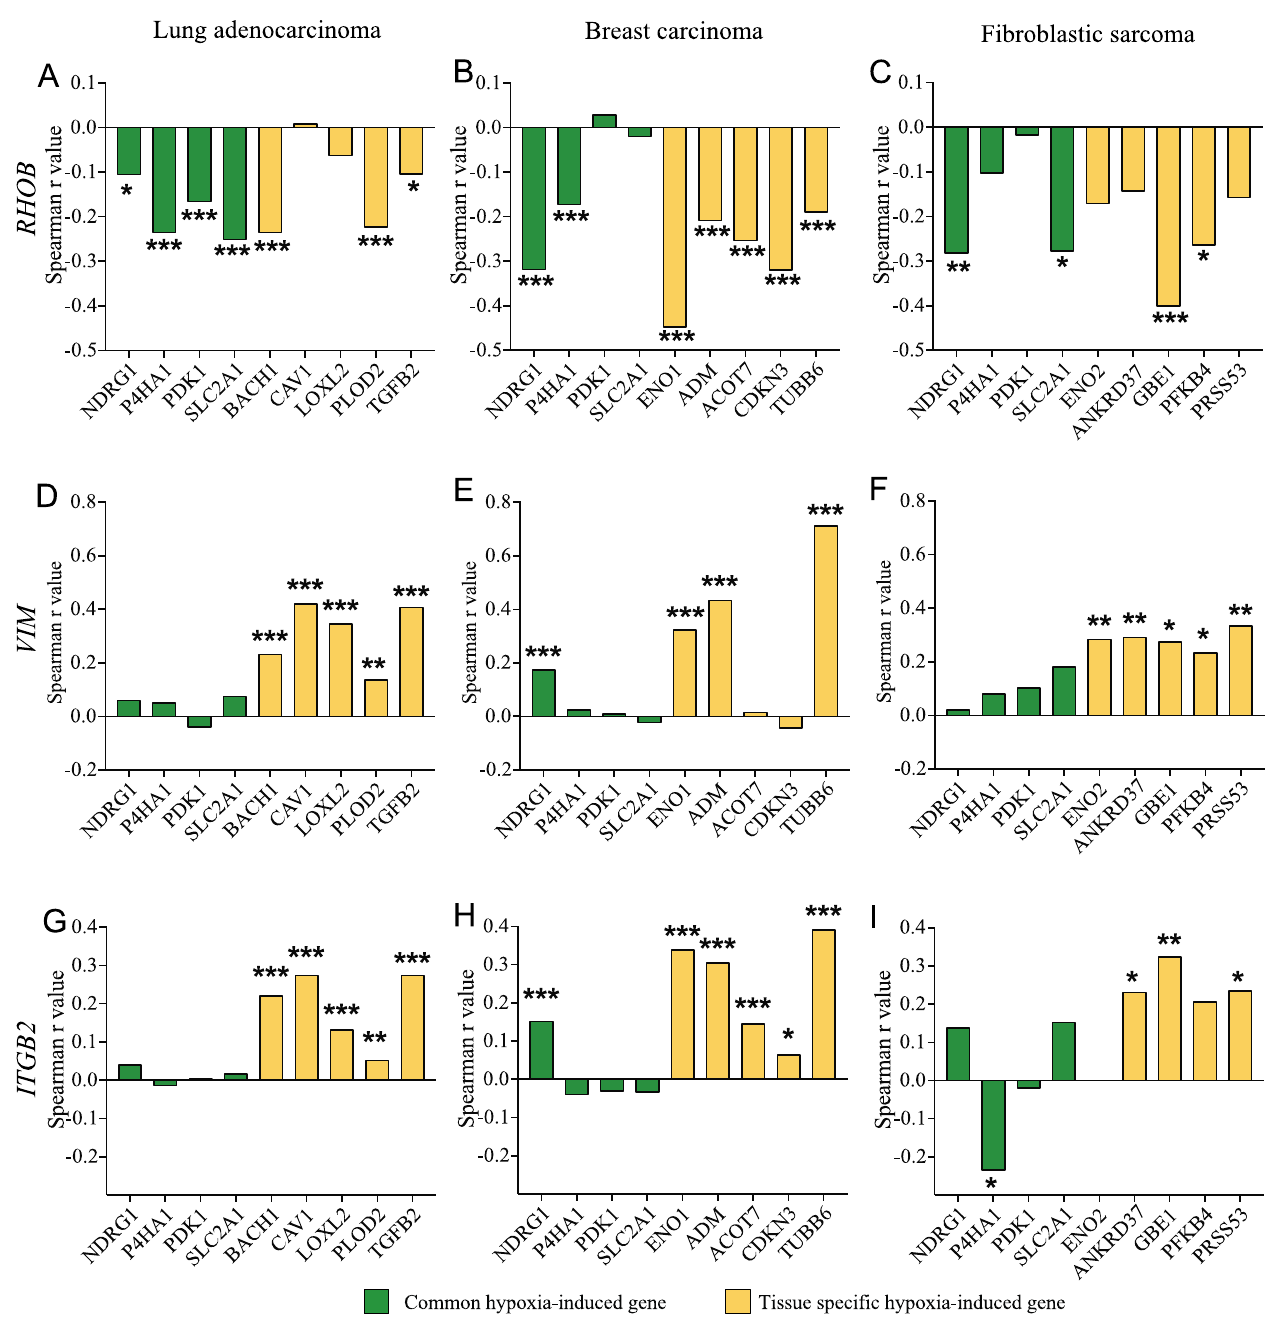
Figure 10. SMAD3-Selective Target Genes Correlate with Hypoxia-Induced Genes in Cancer Patients. TCGA RNA-seq data sets from sarcoma, lung adenocarcinoma and invasive breast cancer patient cohorts were used to assess the correlation coefficient between RHOB ( A – C ), VIM ( D – F ) or ITGB2 (G – I) and genes known to be induced by hypoxia in lung adenocarcinoma ( A , D , G ), breast carcinoma ( B , E , H ) and fibroblastic sarcoma ( C , F , I ) patient cohorts. * p < 0.05; ** p < 0.01; *** p <